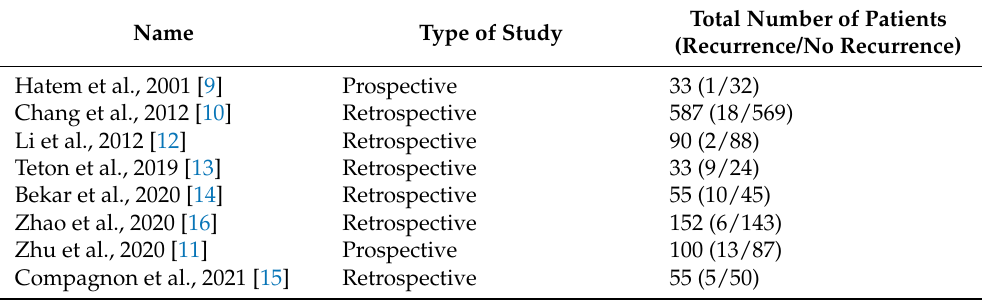
Table 1. Summary of studies included in the